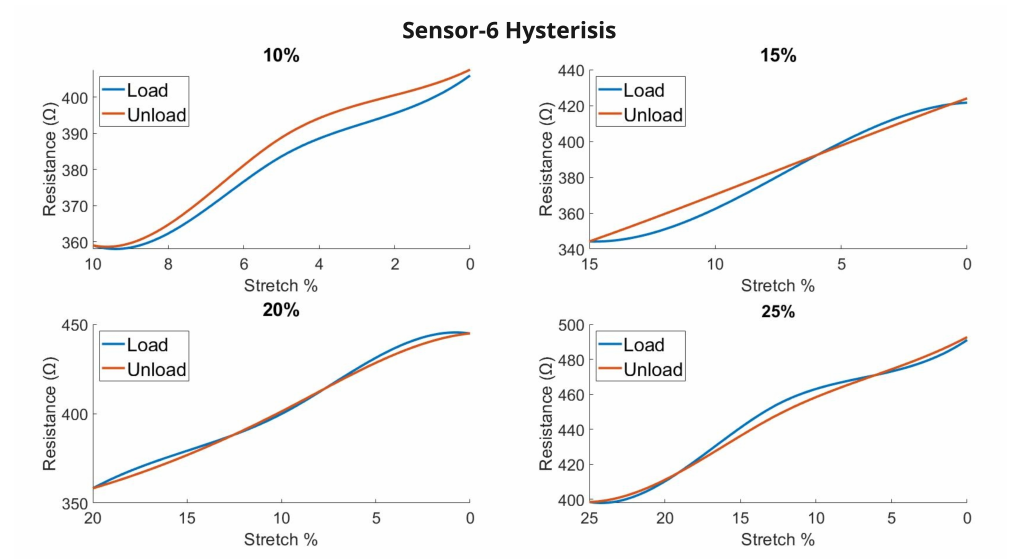
Figure 15. Hysteresis of the knitted sensor (sensor-6) for different stretching